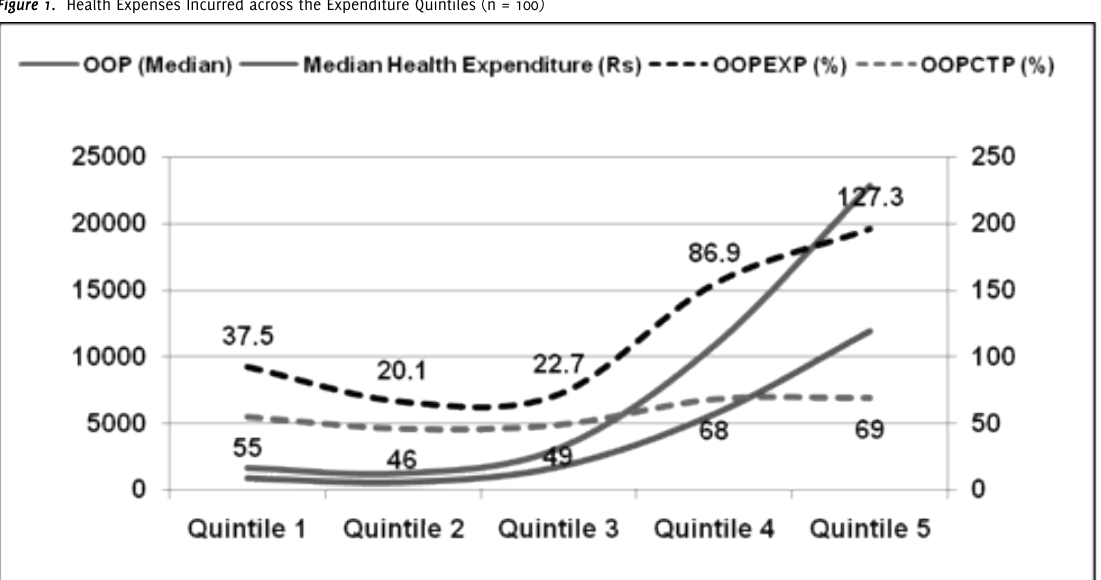
Note: Health Expenditure included both direct and indirect expenses but the OOP takes only direct expenses into Figure 1. Health Expenses Incurred across the Expenditure Quintiles (n = 100)